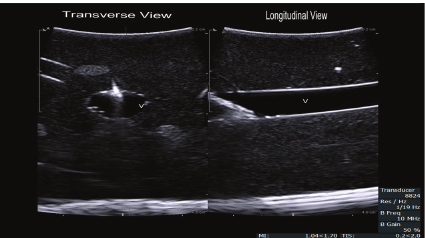
Figure 2: Images from our use in a Blue Phantom training phantom with an 18 gauge 40 millimeter VascularSono cannula (Pajunk USA, Norcross, GA). This is the ideal view that can be obtained with this probe. You can clearly see the needle entering the simulated vein in both views, and the tip is clearly in the lumen in the longitudinal view. V: simulated vein.